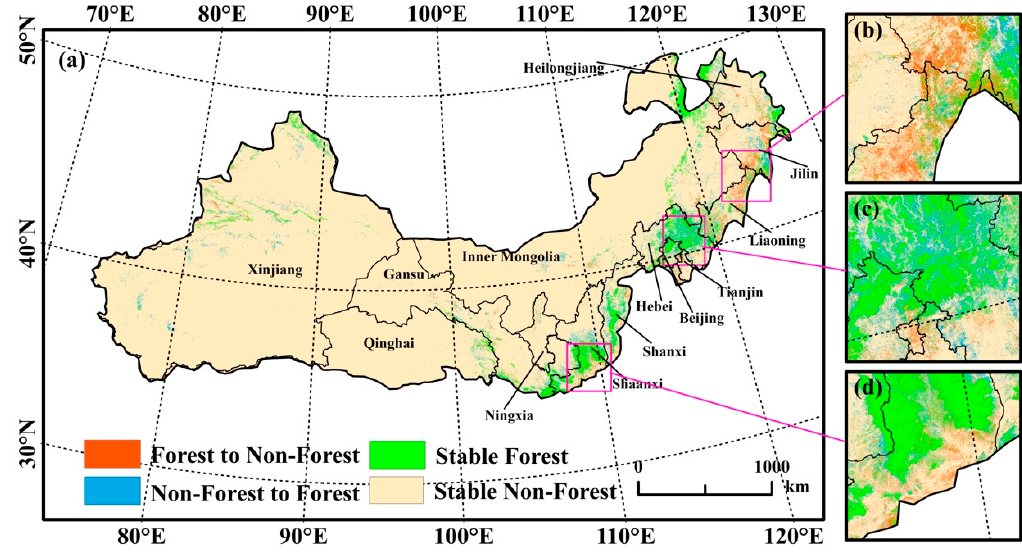
Figure 9. Spatial distribution of forest gain, forest loss, stable forest and stable non-forest in northern China ( a ) and three selected sub-areas ( b – d ) from 2007 to 2017.